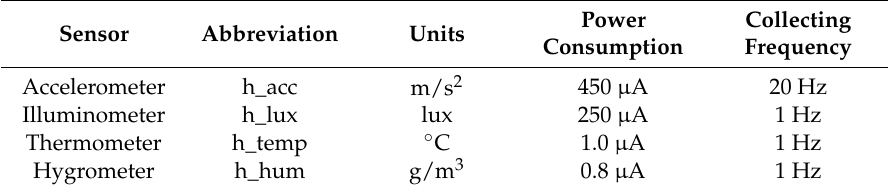
Figure 3. An overview of the proposed method. Table 4. Sensors attached to wrist-wearable devices for